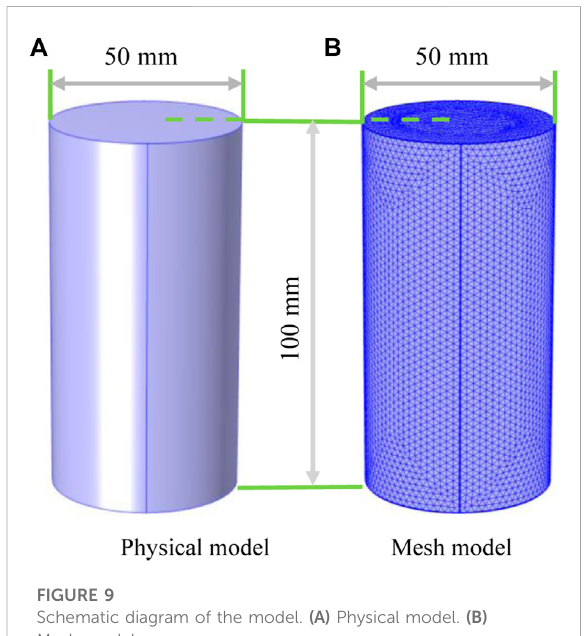
FIGURE 9 Schematic diagram of the model. (A) Physical model. (B) Mesh